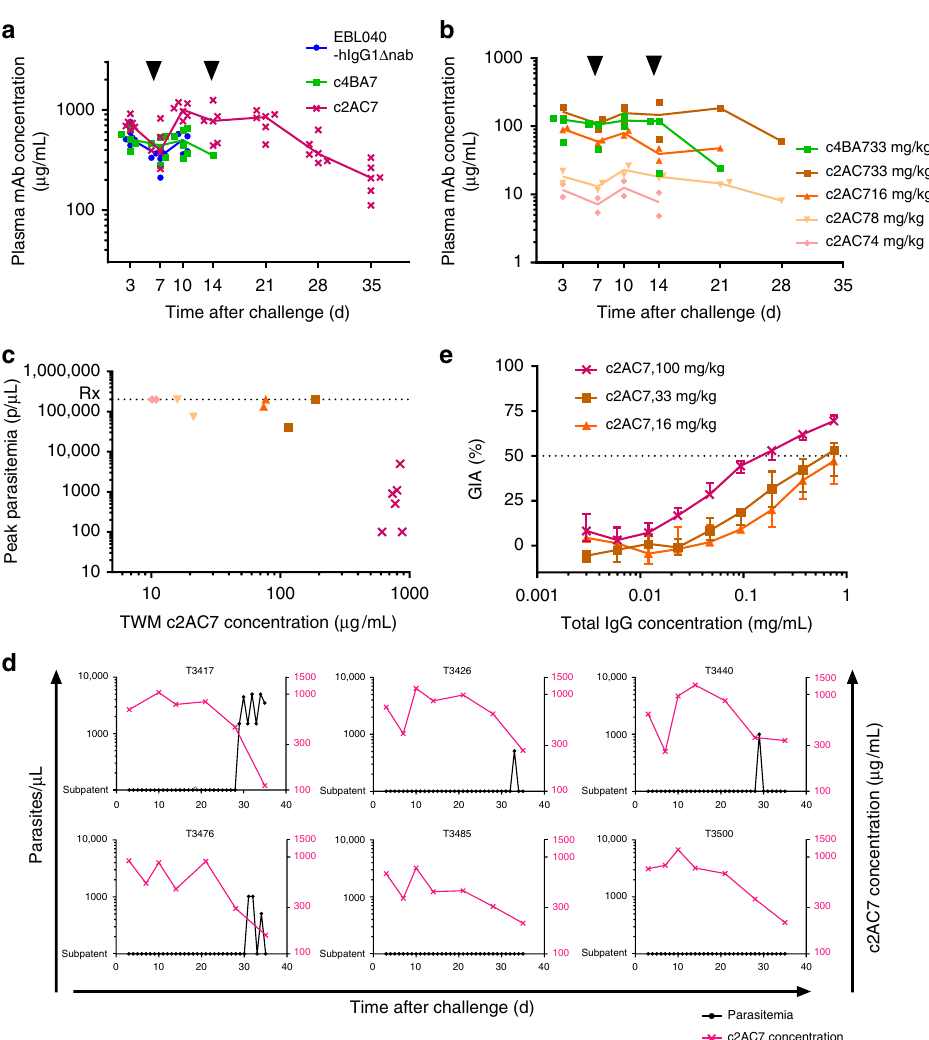
Fig. 3 Plasma mAb concentrations, GIA and outcome. Panels a and b show ELISA-measured plasma mAb concentrations in the high-dose and lower-dosing studies, respectively, up to the point of reaching a treatment endpoint. Points indicate data from individual animals; lines link group medians. Arrowheads indicate mAb top-up dose administration on days 7 and 14. Panel c shows the relationship between time-weighted mean (TWM) c2AC7 mAb concentration and peak parasitemia in individual animals, combining data from the high-dose and lower-dosing studies (Spearman correlation coef fi cient r = − 0.8, P = 0.001). Panel d shows timecourses of parasitemia (black circles, left axis) against ELISA-measured c2AC7 concentrations (pink crosses, S right axis). Each subplot represents an individual animal from the 100 mg/kg c2AC7 group. Parasitemia data is as shown in panel 2 c and ELISA data is as shown in panel 3 a . Panel e shows the relationship between concentration of total protein G-puri fi ed IgG and GIA (against FVO parasites). Due to small sample volumes, samples from pairs of Aotus (collected on day 10 after challenge) were pooled prior to IgG puri fi cation. Results shown for the 100 mg/kg c2AC7 group ( n = 6 animals) are the median (points) and range (error bars) of the three such pairs, with each datum being the median of three independent assays. Results for the 33 and 16 mg/kg c2AC7 groups ( n = 2 animals each) are each from a single pair of animals, showing the median (points) and range (error bars) of three independent assays. All assays had triplicate wells at each tested IgG concentration. Results are not shown for animals from other groups, in which GIA did not reach 50% at the maximum tested concentration: GIA was <20% at 0.75 mg/mL of IgG from animals in the EBL040, c4BA7 and no mAb control groups, and <30% at 0.75 mg/mL for the 8 and 4 mg/kg c2AC7